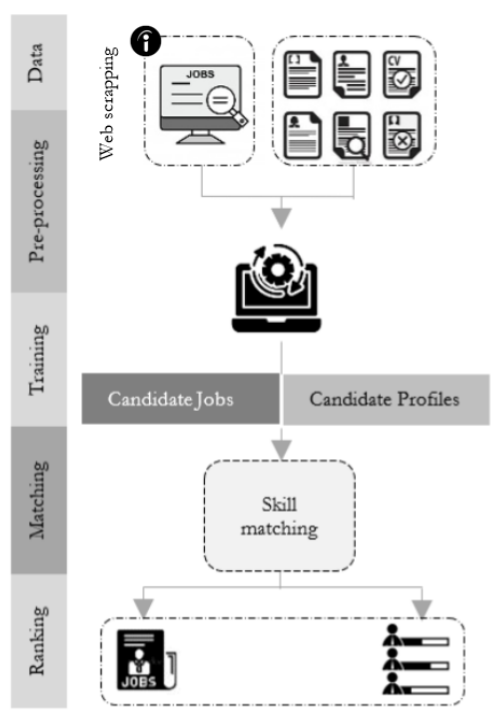
Figure 3. Overview of Bi-directional